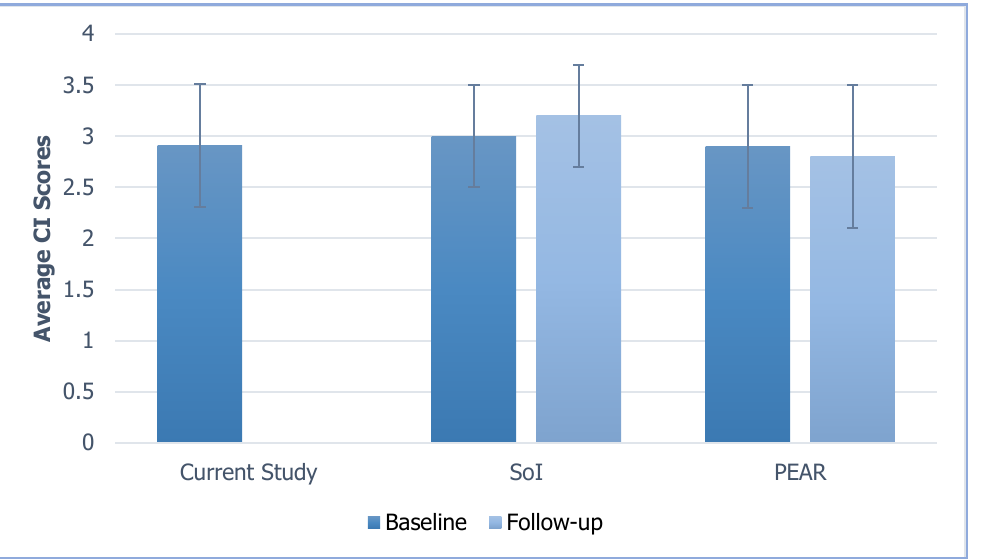
Figure 4. Comparison of CI Scores With Those Reported in Martinez et al.